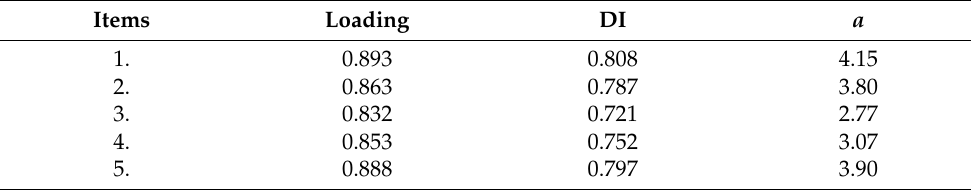
Table 2. OASIS factor loadings, discrimination indices and discrimination parameter a .